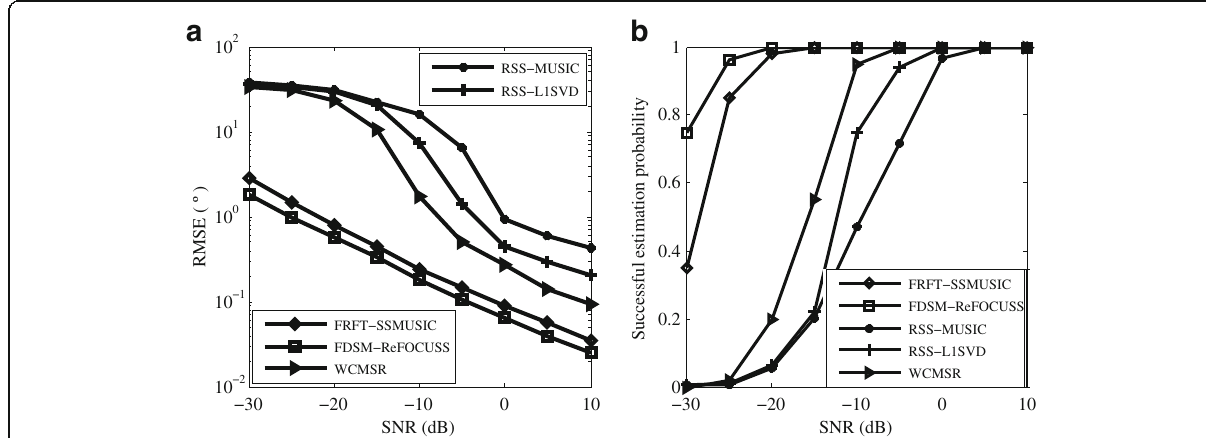
Fig. 4 Estimation performances versus SNR for coherent wideband LFM signals (large angle interval). a Estimation error. b Successful estimation